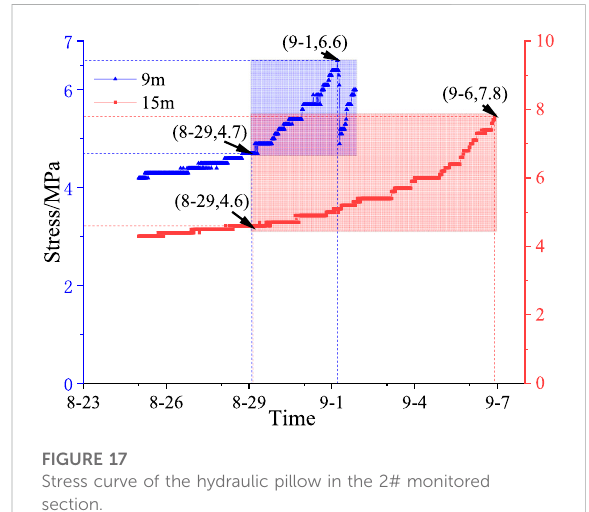
FIGURE 17 Stress curve of the hydraulic pillow in the 2# monitored